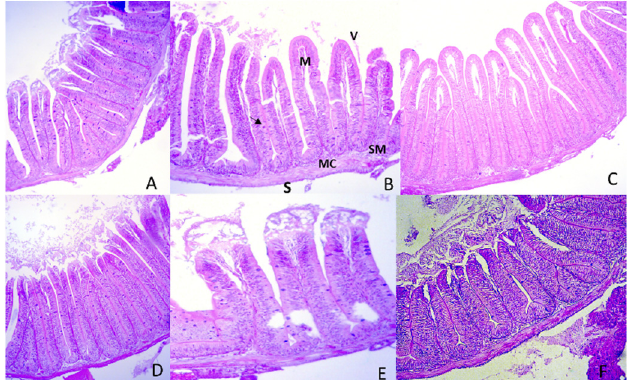
Figure 3. Relationship between intestinal villi morphometry of Nile tilapia juveniles and dietary fumaric acid levels through 35 days: ( a ) intestinal villi height; ( b ) intestinal villi width. FA: fumaric acid level (g/kg); T: time (days).